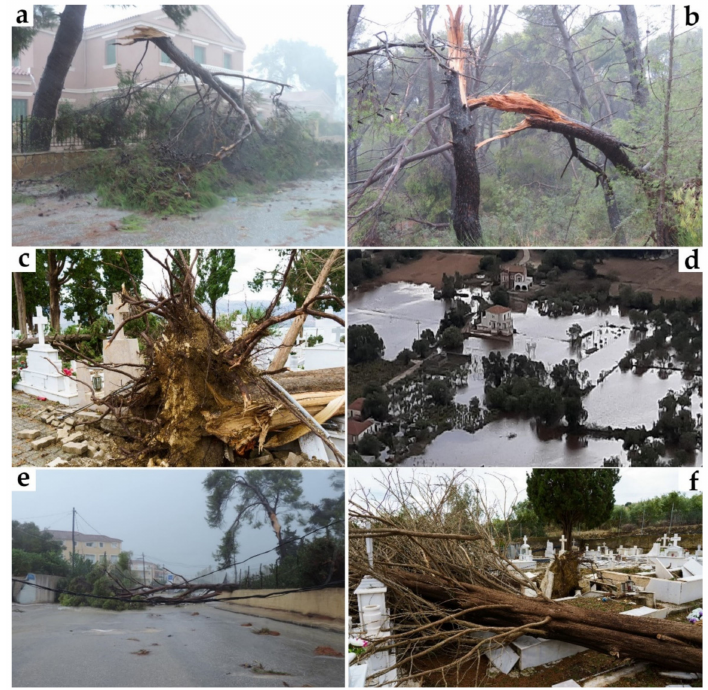
Figure 10. Characteristic images of the impacts of Ianos Medicane on vegetation ( a – f